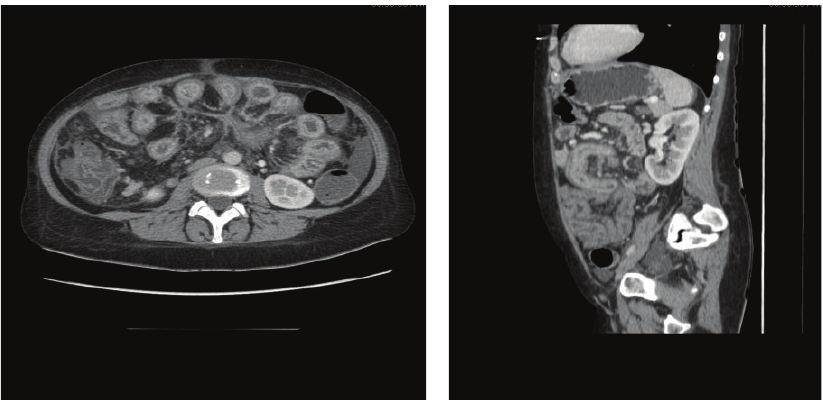
Figure 1: Abdominal computed tomography (CT). CT of the abdomen shows ascites. Liver, pancreas, spleen, and kidneys look normal. Thickened wall of sigmoid and ascending colon, cecum, and a significant part of the ileum, inflammatory changes. Numerous, enlarged mesenteric lymph